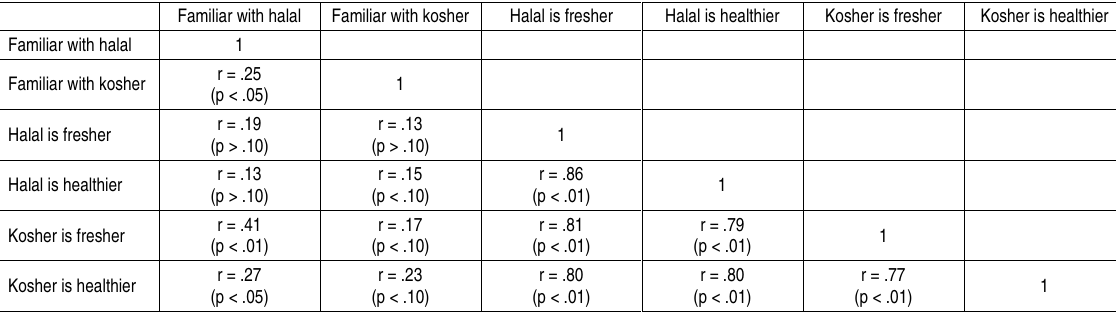
Table 2. Familiarity and expenditures on halal and kosher –